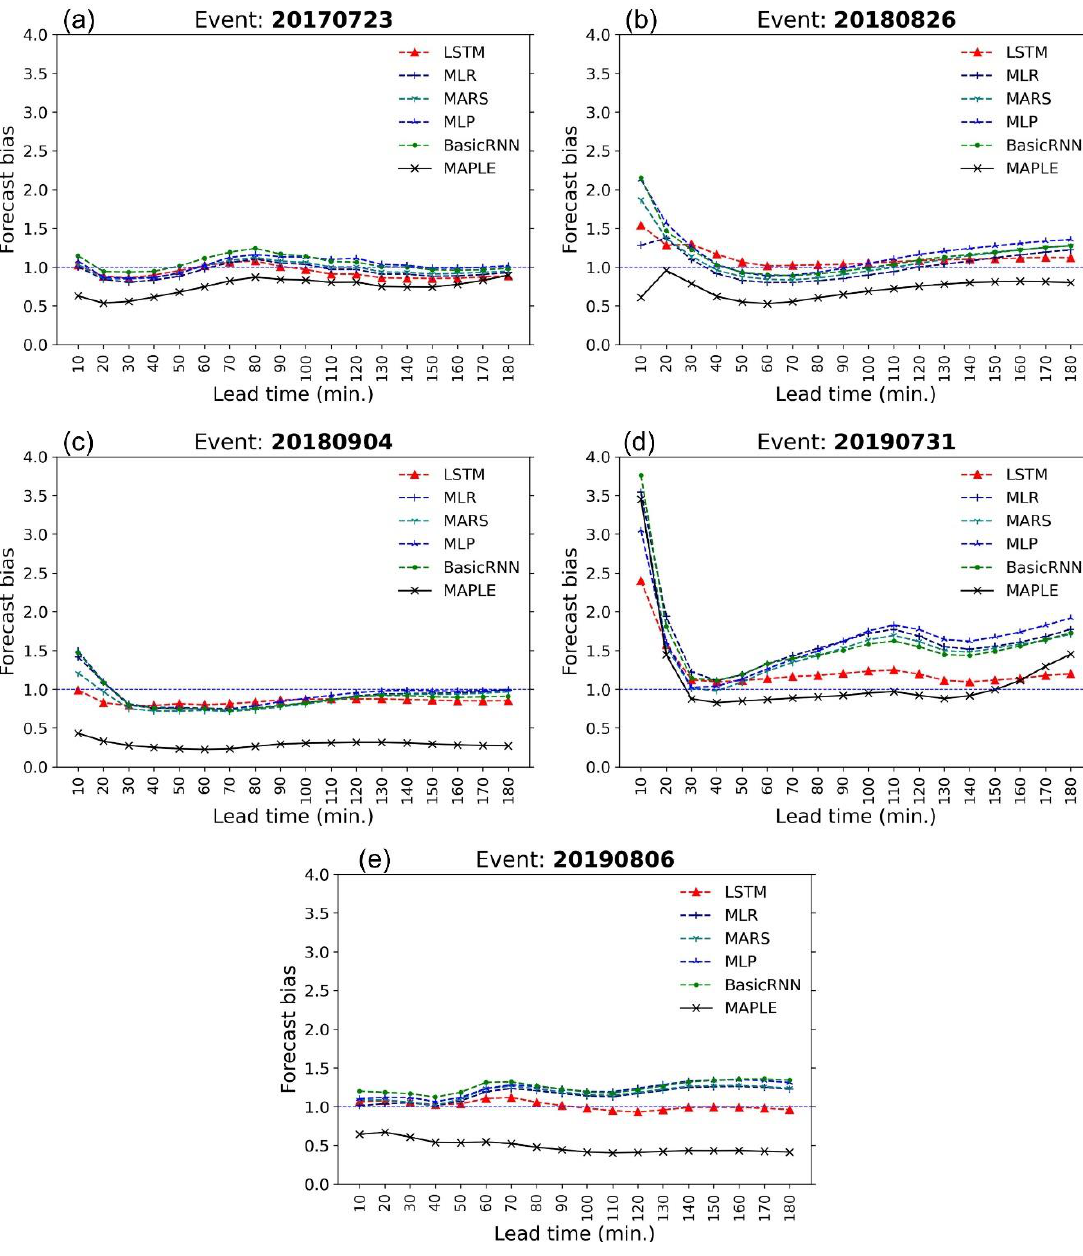
Figure 8. Forecast bias ( FB ) performance of the forecasted rainfall from the MAPLE system and the models in reproducing 180 min forecast rainfall in the 5 test events: ( a ) 20170723 event, ( b ) 20180826 event, ( c ) 20180904 event, ( d ) 20190731 event, and ( e ) 20190806 event. The blue line indicates no bias in total 180 min forecast rainfall with observed rainfall.